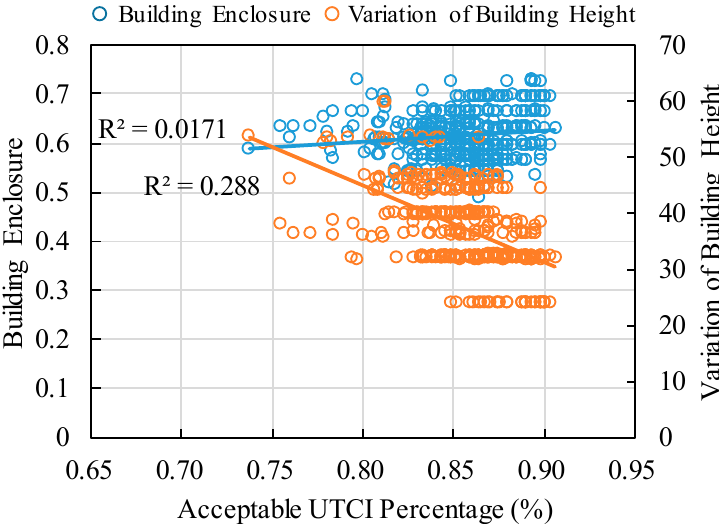
Figure 16. Correlation results of building density, plot ratio, and acceptable UTCI percentage at street level.